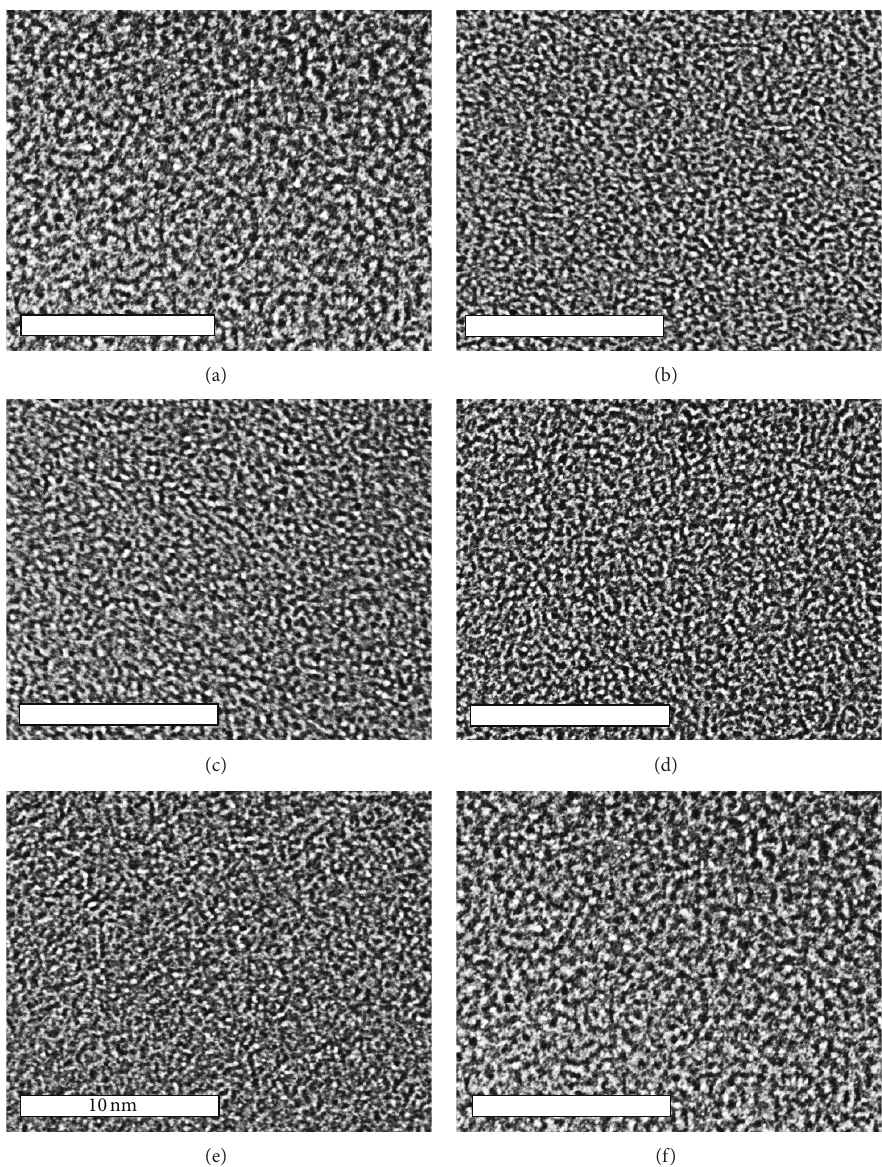
Figure 8: TEM images of the PBDTTT-C: PC 70 BM films treated at 70 ∘ C for control (a), 1 hour (b), 2 hours (c), 3 hours (d), 5 hours (e), and 18 hours